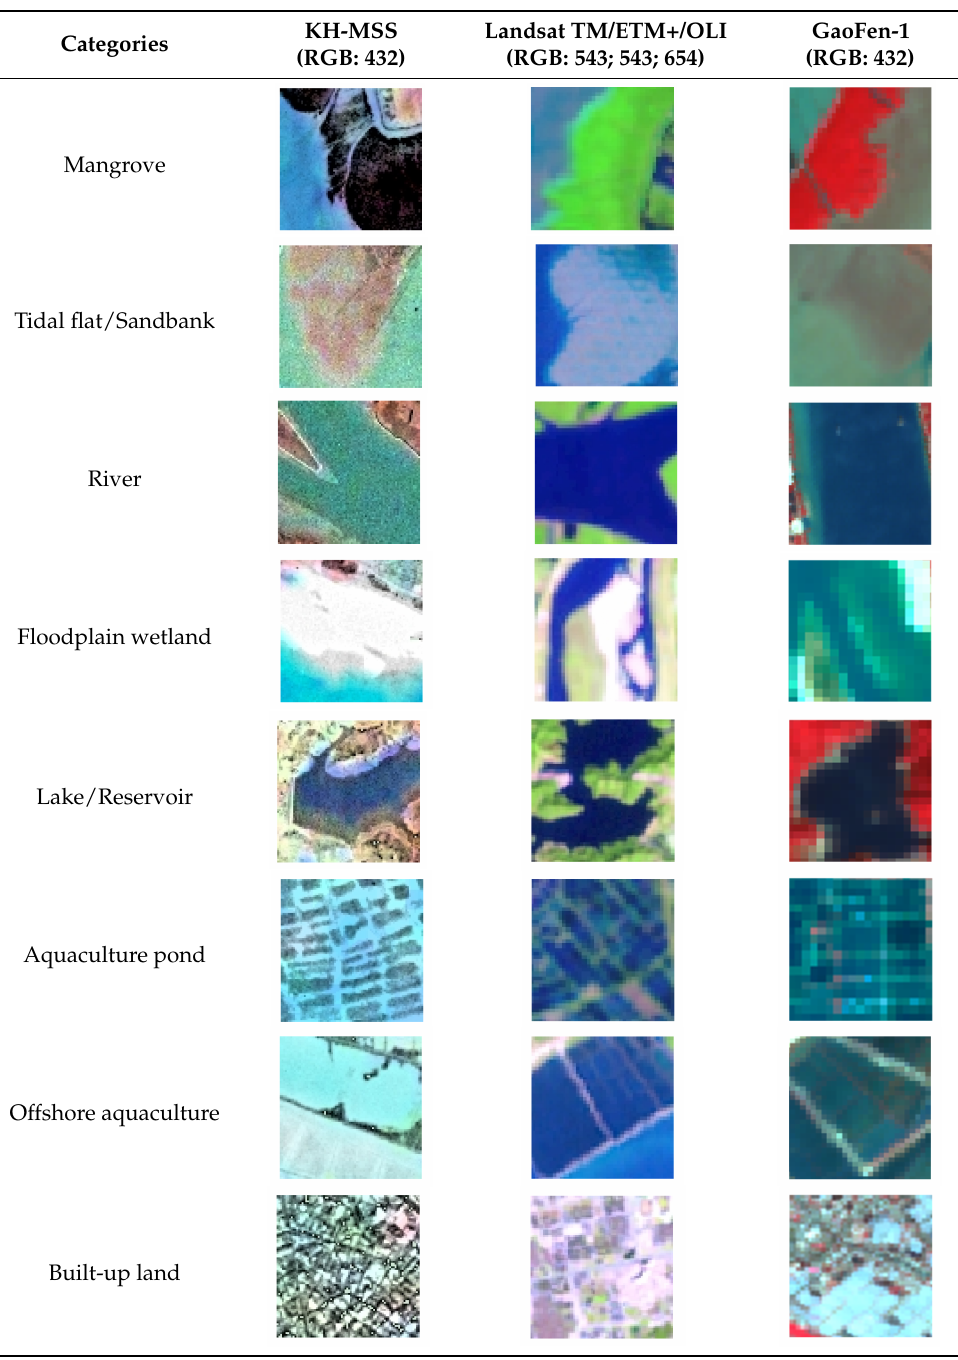
Table 3. Image interpretation signs for different data sources used in this